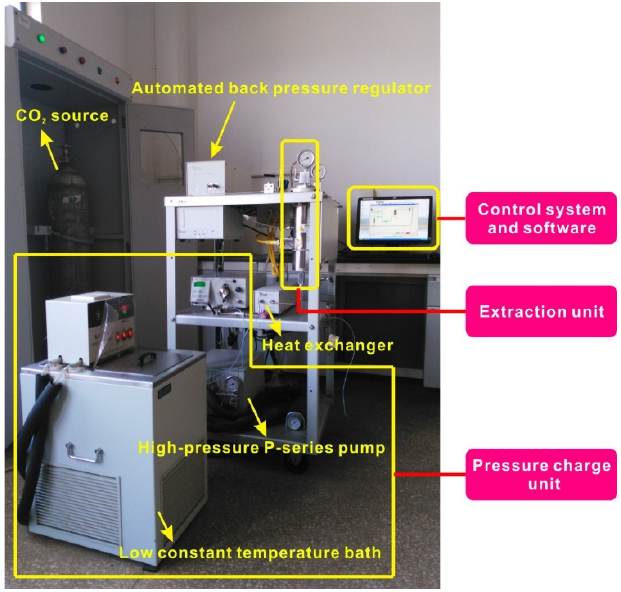
Figure 2. Dynamic supercritical fluid geochemical interaction